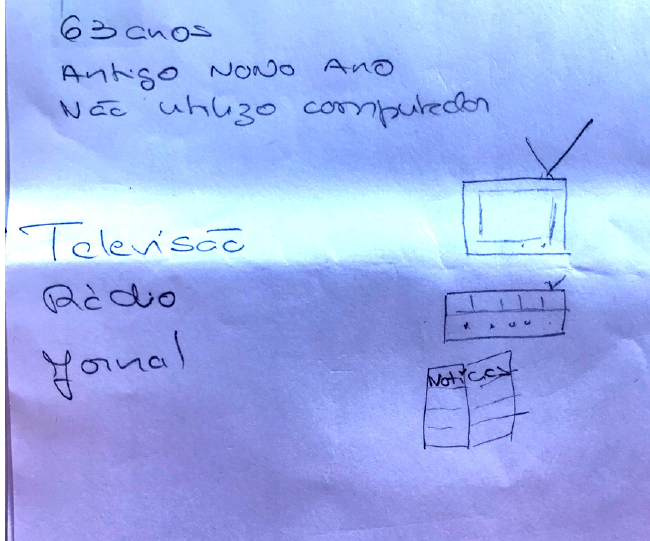
Figure 1. Antónia’s (63) drawings point to traditional media consumption (television, radio, and print newspapers) and include a statement saying she does not use computers. Note: The text in the drawing reads “63 years old; Former ninth grade; I don’t use the computer. Television; Radio;